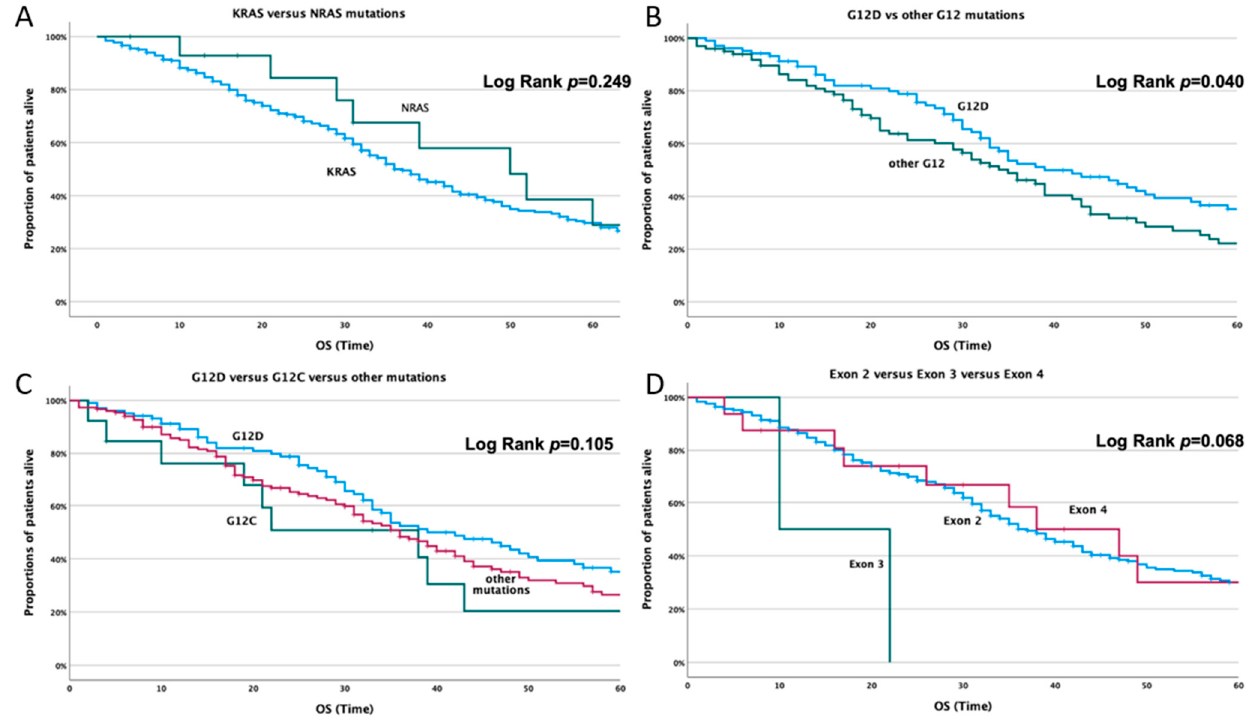
Figure 2. OS regarding ( A ) KRAS- and NRAS -mutated patients; ( B ) KRAS G12D and other KRAS G12 mutations; ( C ) KRAS G12D, G12C and other G12 mutations; ( D ) KRAS exon 2, exon 3 and exon 4 mutations.